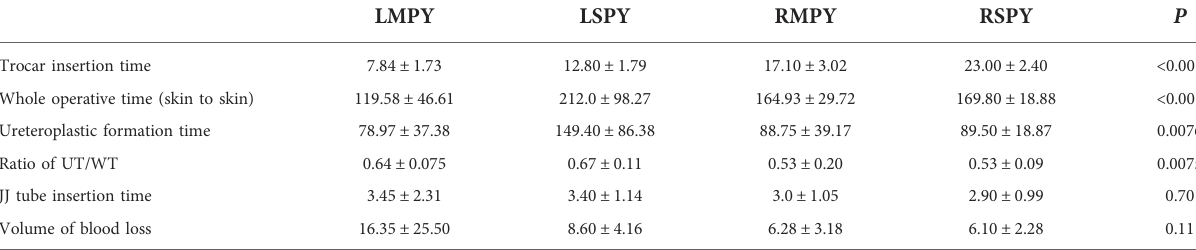
TABLE 2 Patients ’ intraoperative data.